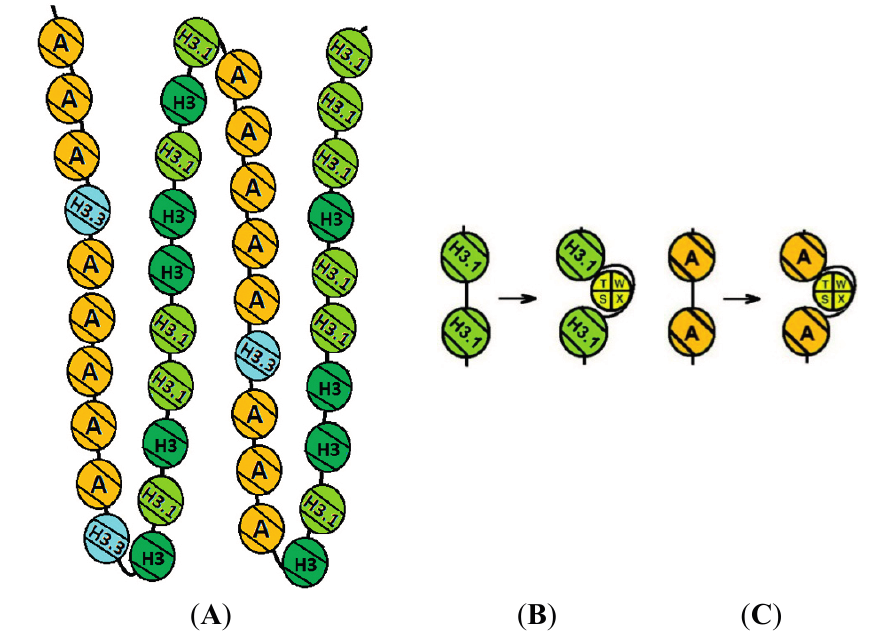
Figure 6. Boustrophedon kinetochore structure [96]. ( A ) One loop of a potential centromeric chromatin structure at late S phase. CENP-A dominates one stretch of nucleosomes while H3 variants are distributed on the folded-back strand. The CCAN complex is supposed to fold between a CENP-A on the one and H3.1 on the other strand [99]; ( B , C ) CENP-T/W/S/X may be wrapped around by DNA in cis to CENP-A-containing ( C ) or H3.1-containing nucleosomes ( B